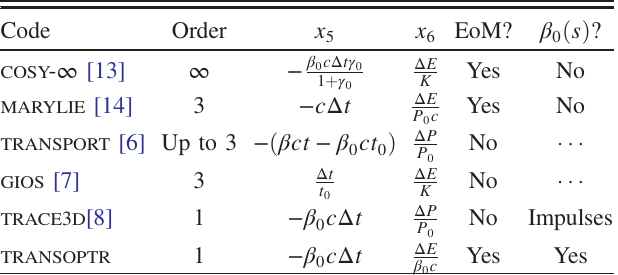
TABLE I. Various codes and their longitudinal coordinate definitions. The fifth column (EoM?) refers to whether the equations of motion are integrated as opposed to having stored transfer matrices. The rightmost column refers to whether the reference particle can be accelerated within an